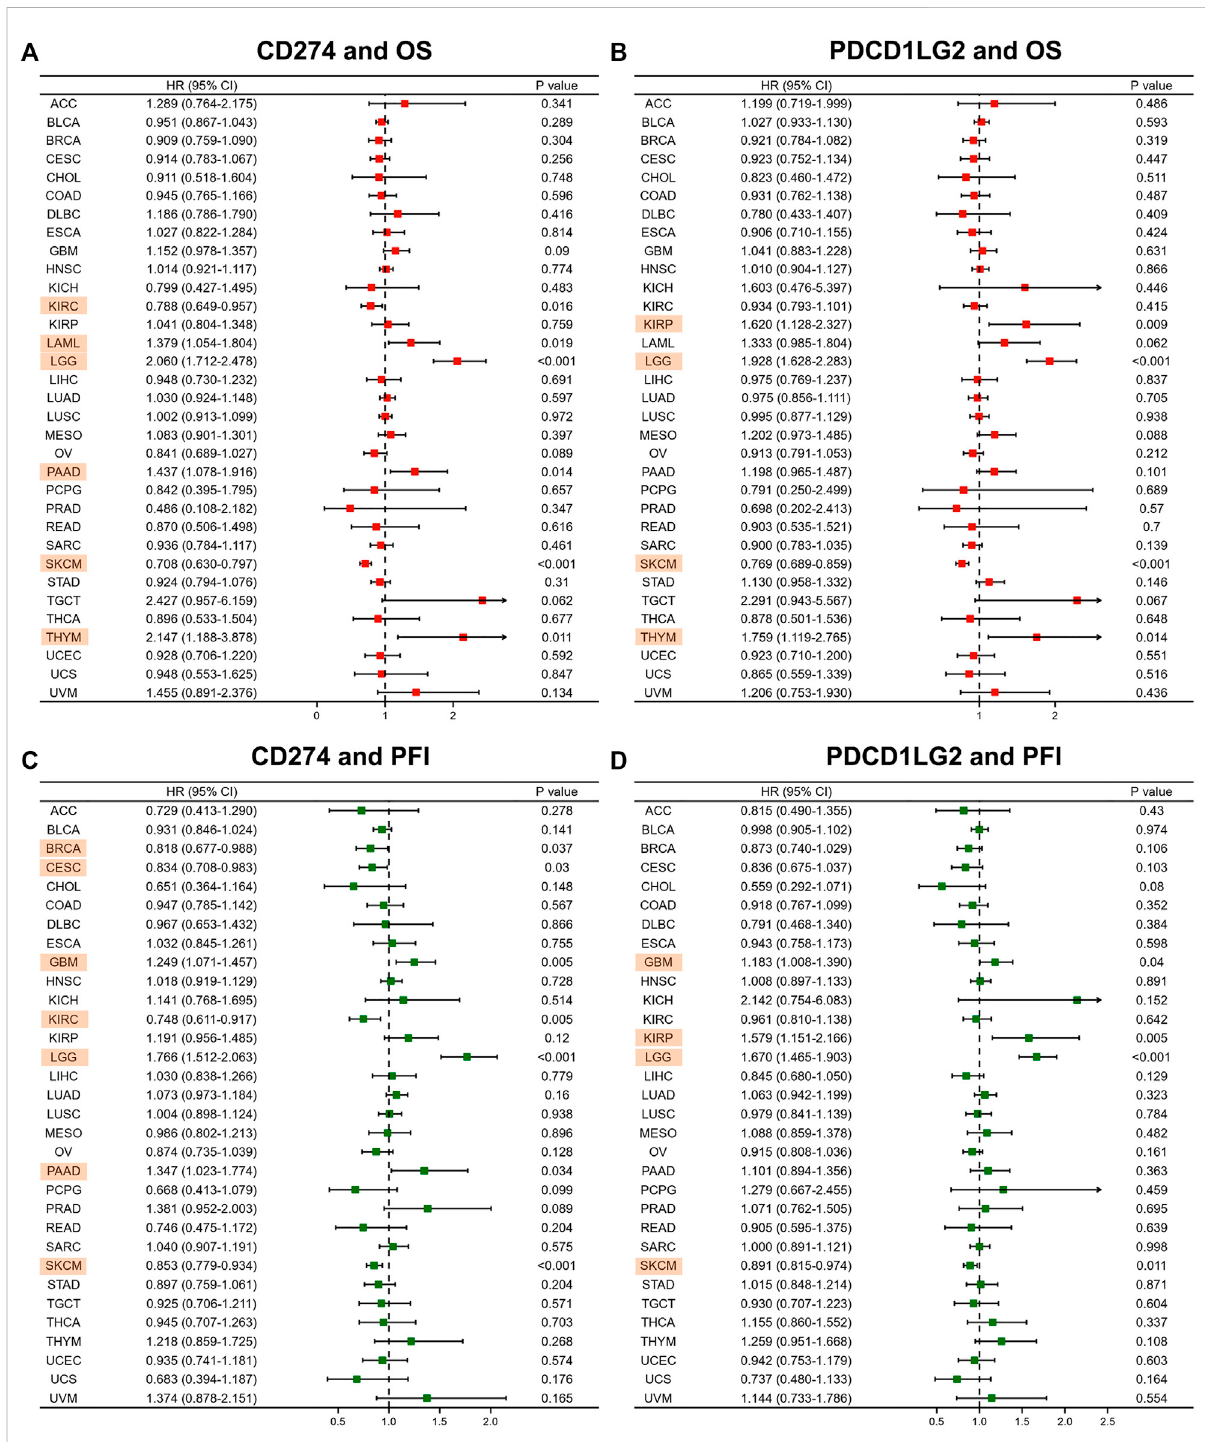
FIGURE 3 CD274/PDCD1LG2 is related to different prognoses. Forest plot showing the association of CD274 and PDCD1LG2 with (A,B) OS and (C,D) PFI. Cancers with p < 0.05 are